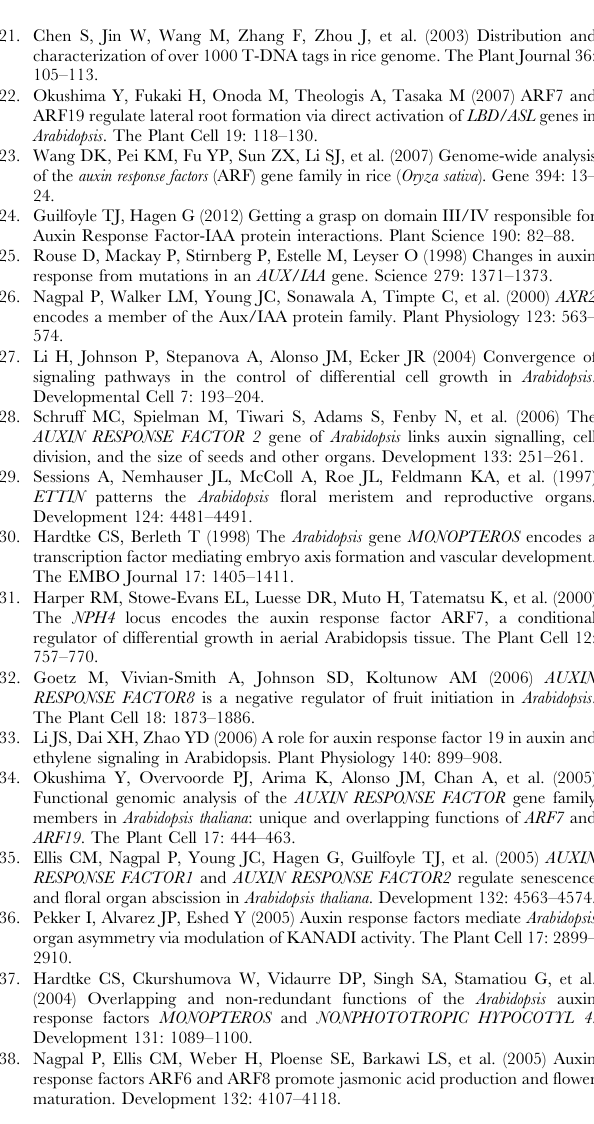
base (SB) of 7-d-old wild-type seedlings, and in stem (S), leaf (L) and panicle (P) of adult plants. Figure S5 Phenotypes of transgenic rice. Phenotypes of transgenic rice over expressing OsARF6(WS) (A), OsARF12(WS) (B), OsARF16(WS) (C), OsARF17(WS) (D) and OsARF25(WS) (E) in the Osiaa23-3 background. From left to right are wild type, Osiaa23-3 and two independent transgenic lines in the Osiaa23-3 background. Bars =2 cm. The lowers are RT-PCR results of these transgenic lines. Figure S6 Root tips of transgenic rice over expressing OsARF(WS)s . From left to right are wild type, Osiaa23-3 mutant and five transgenic rice over expressing different OsARF(WS)s in the background of Osiaa23-3 . None of the transgenic rice recovered the root tip defect. Bars = 0.5 mm. Table S1 The microarray results of gene expression profile in rice root tip. Total RNA was extracted from root tips